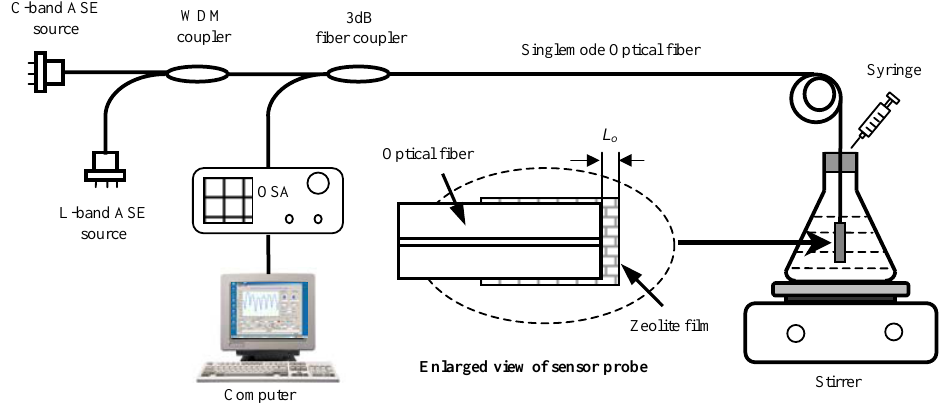
Figure 3. System configuration for sensor interrogation and